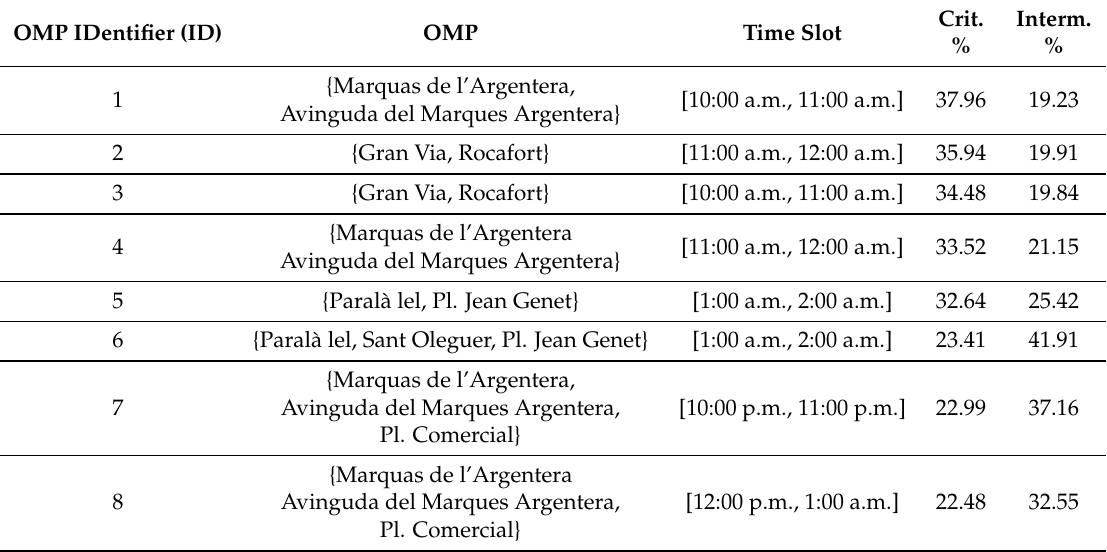
Table 5. Bicing (Barcelona). Groups of stations with maximal criticality in different hourly time slots.